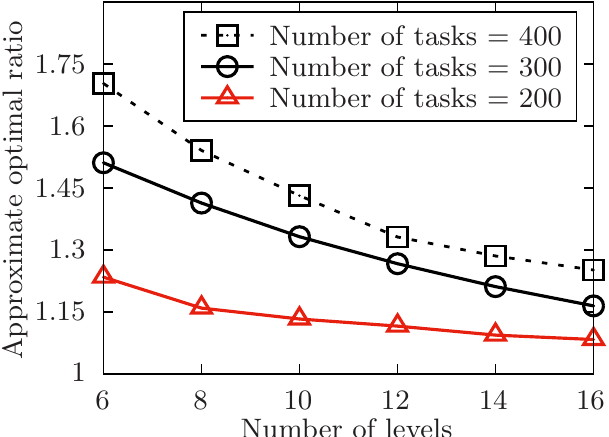
Figure 5. The approximate optimal ratio of the proposed algorithm vs. different l when m = 200,300,400.